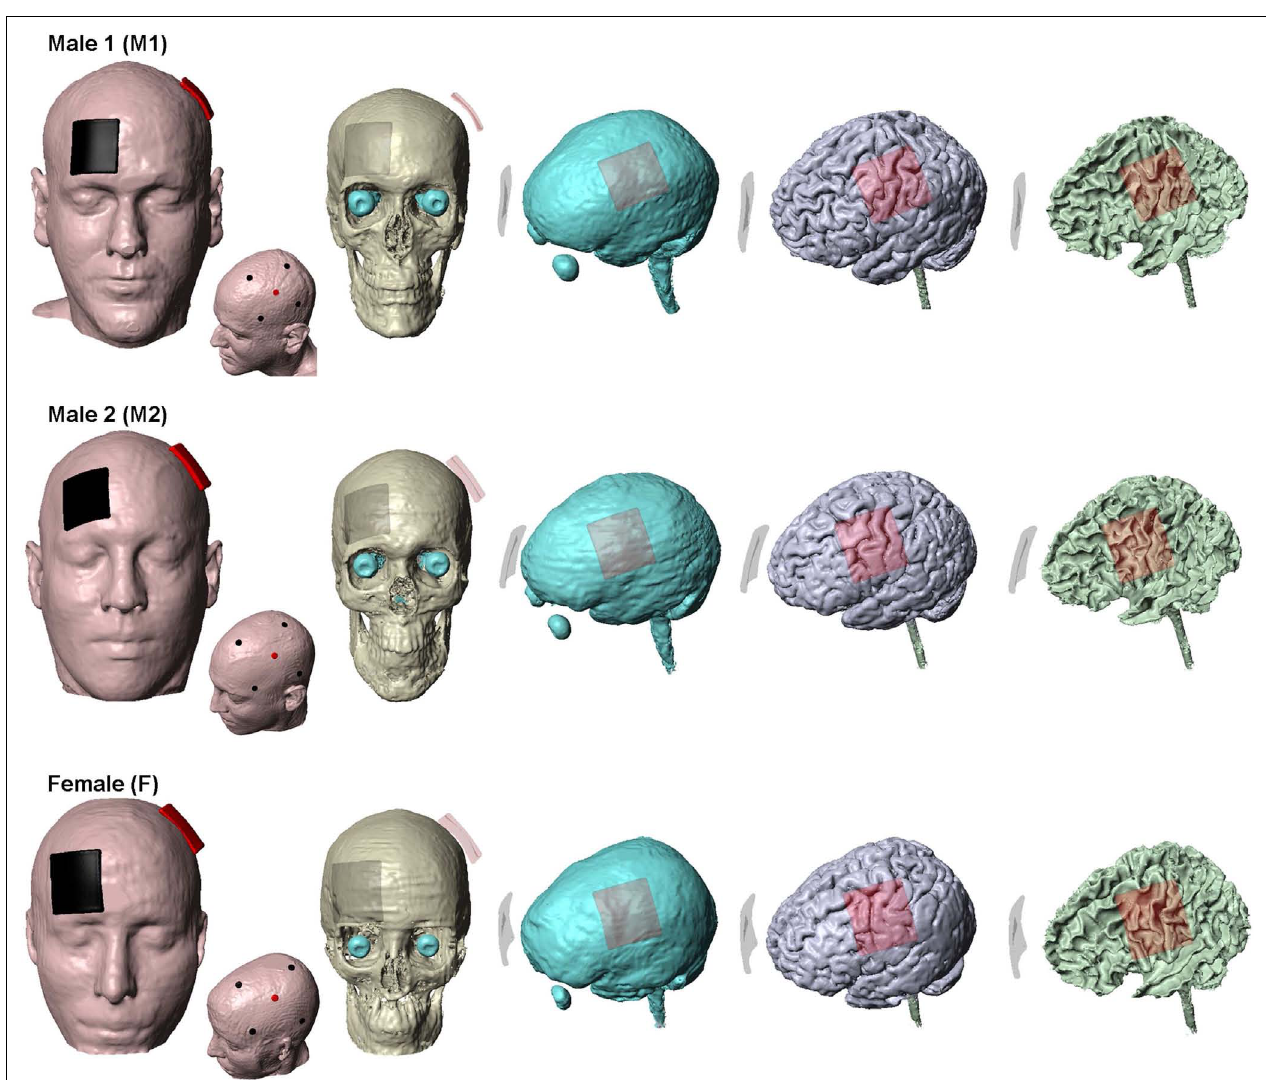
electrode is placed over left M1 and the cathode (negative) electrode over the contralateral-supraorbita. For the 4 × 1-HD montage, the anode electrode is placed over left M1 and is surrounded by four cathode electrodes. Red: anode (positive) electrode and Black: cathode (negative)